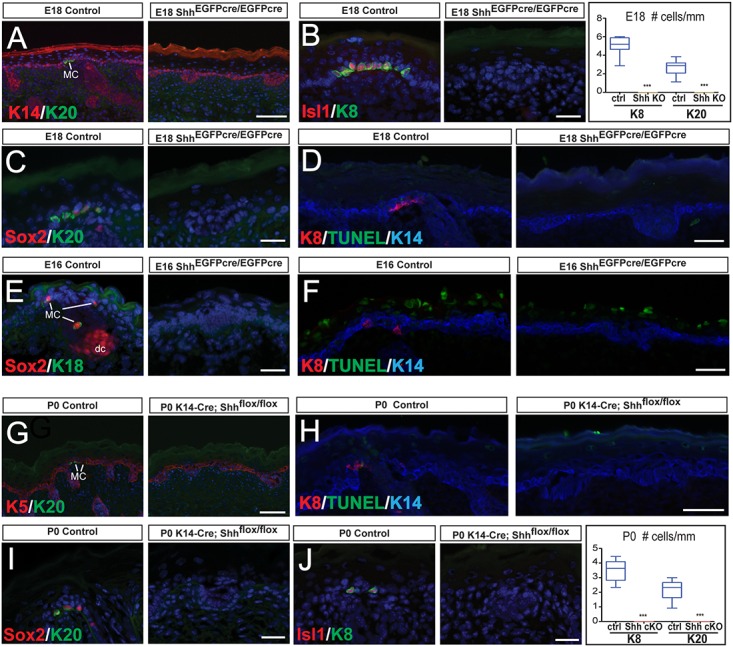
Shh signaling activity is required for Merkel cell formation.(A-C) IF stainings for Merkel cell (MC) markers Krt20 (K20) (A,C), Isl1 (B), Krt8 (K8) (B), and Sox2 (C) show a complete absence of Merkel cells in E18 Shh KO (ShhEGFPcre/EGFPcre) mice compared to control (ctrl). Quantification of Krt8(+) and Krt20(+) Merkel cells in control and Shh KO E18 skin (right panel of B) (Krt8 p = 0.0005 and Krt20 p = 0.0001). (D) TUNEL staining shows no increase in apoptosis in the skin of E18 Shh KO mice. (E) IF stainings for Merkel cell markers Krt18 (K18) and Sox2 show a complete absence of Merkel cells in E16 Shh KO mice when compared to control. Sox2 also labels the dermal condensate (dc). (F) TUNEL staining shows no increase in apoptosis in the Krt14(+) basal layer of E16 Shh KO mice when compared to control. Note that cells undergoing cornification in the suprabasal layers are TUNEL(+), as previously reported [33]. (G,I,J) IF stainings for Merkel cell (MC) markers Krt20 (G,I), Krt8 (J), Isl1 (J), and Sox2 (I) show a complete absence of Merkel cells in P0 Shh epidermis-conditional knockout (Shh cKO) (K14-Cre; Shhflox/flox) mice compared to control. Quantification of Krt8(+) and Krt20(+) Merkel cells in control and Shh cKO P0 skin (right panel of J) (both p<0.0001). (H) TUNEL staining shows no increase in apoptosis in the Krt14(+) layer P0 K14-Cre; Shhflox/flox mice. Note that cells undergoing cornification in the suprabasal layers are TUNEL(+). Scale bars: (A,G): 100μm; (B-F; H-J): 25 μm.